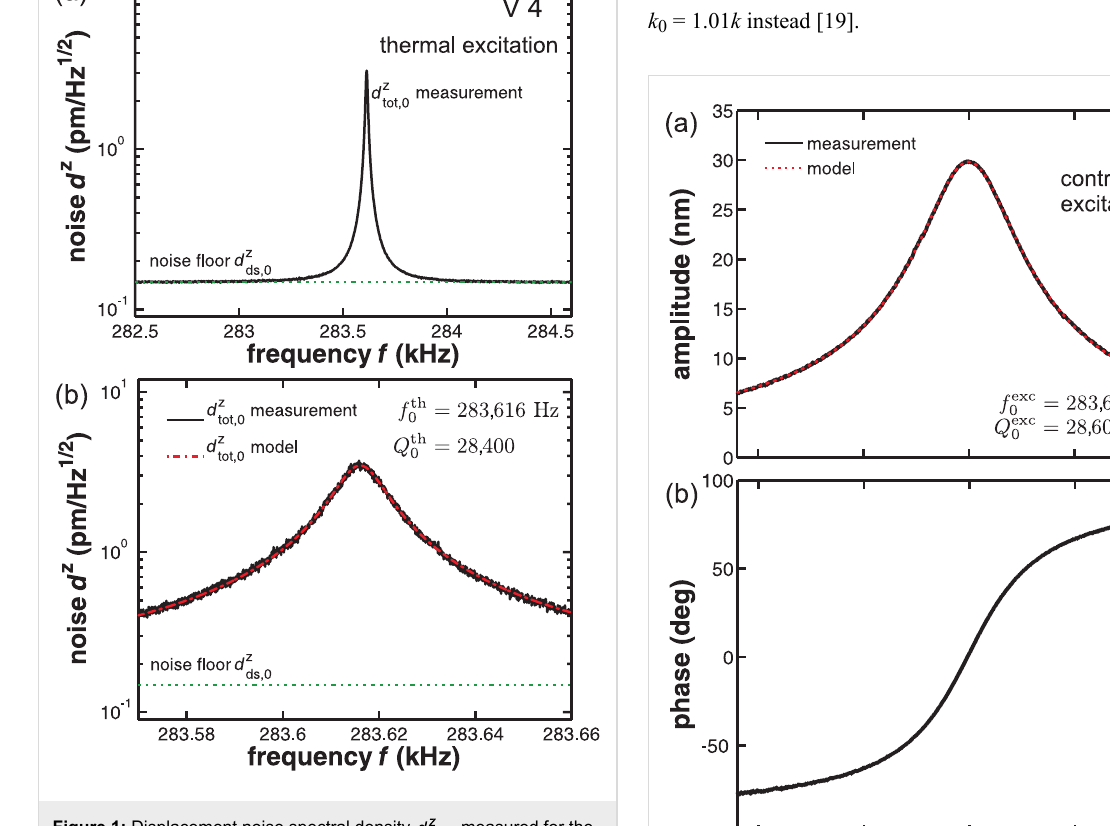
Figure 1: Displacement noise spectral density measured for the fundamental mode of cantilever V 4. Measurements represent the average of 50,000 spectra. (a) Measurement yielding the detection- system noise floor (dotted line). (b) Determination of , and by a fit of Equation 3 to the measured spectrum (dash-dotted line).